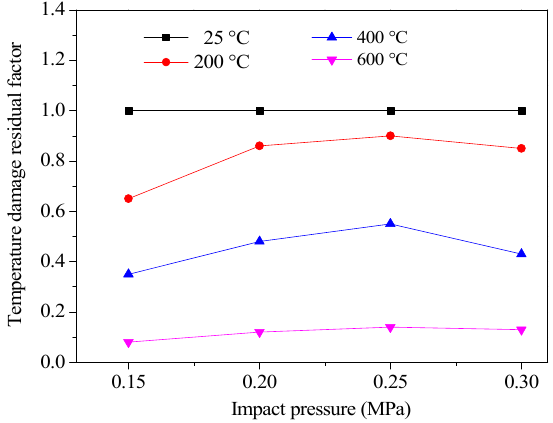
Figure 11. The temperature damage residual factor vs. the impact pressure.